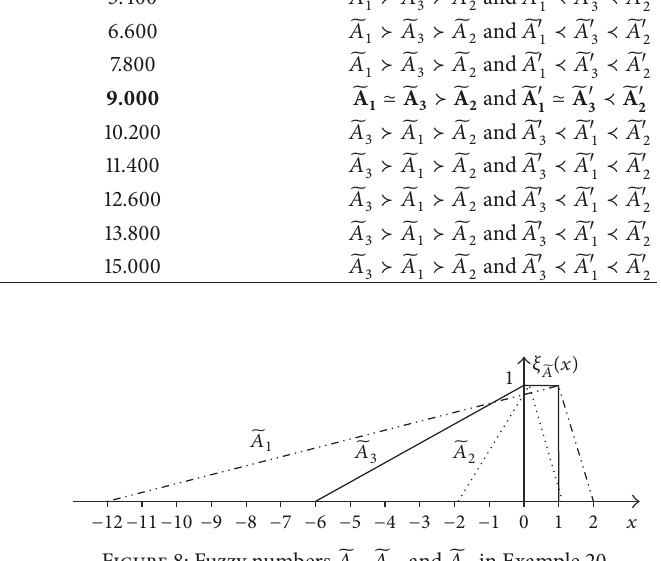
Figure 8: Fuzzy numbers fuzzy numbers, 13/12) , which are adapted from [66] and shown in Figure